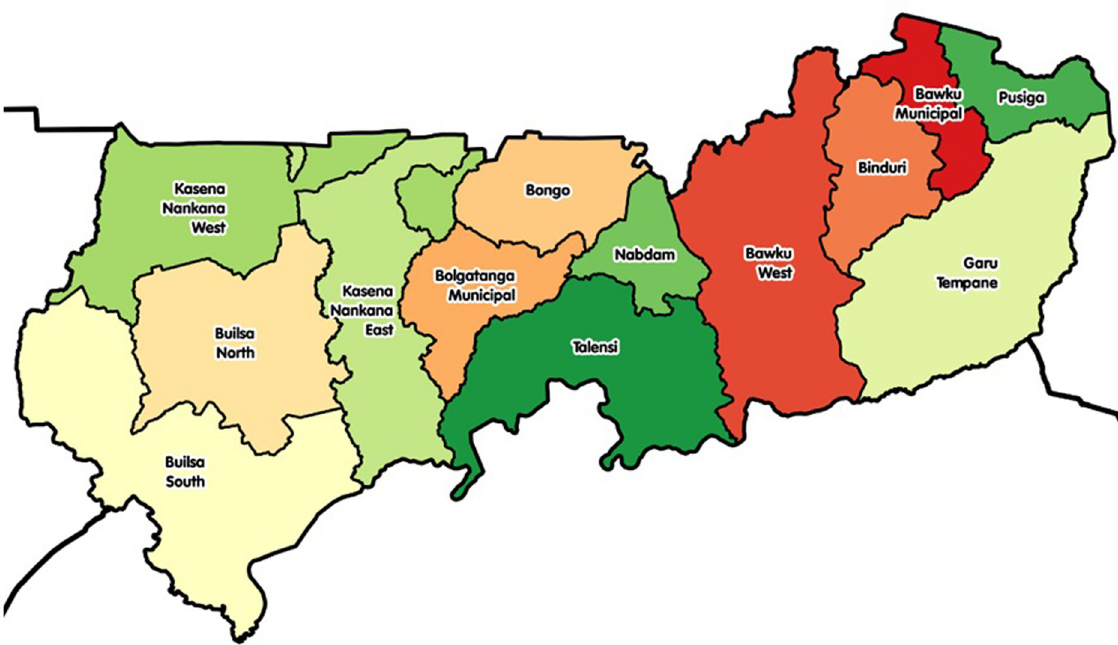
Fig 1. A map of Upper East region showing its